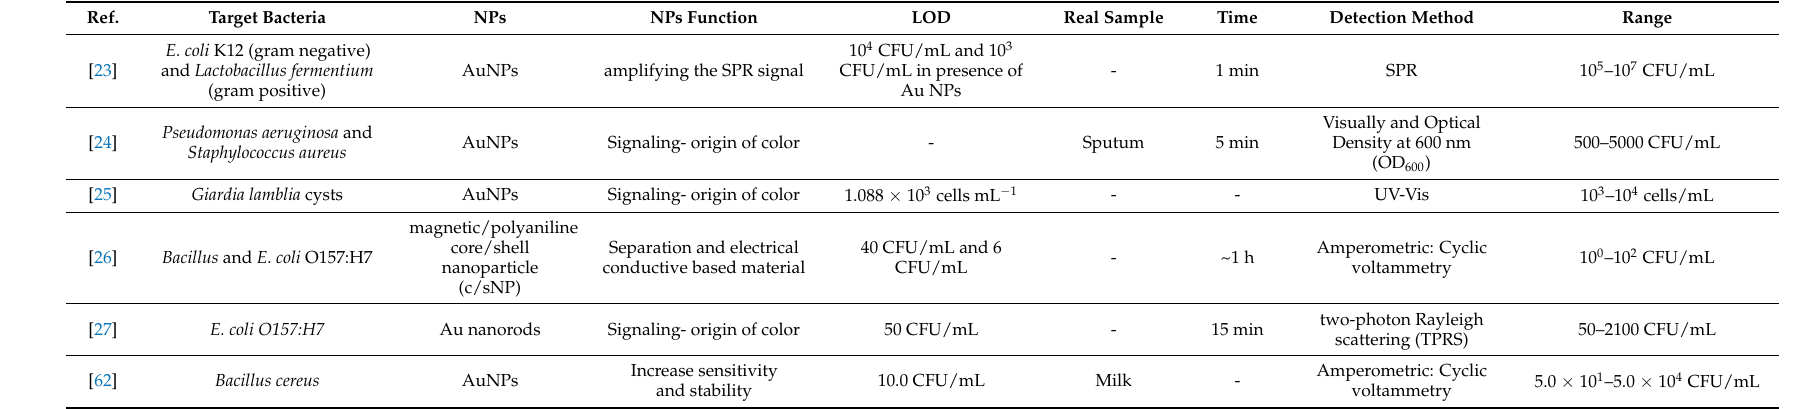
Table 2. Immuno-based biosensors for bacteria